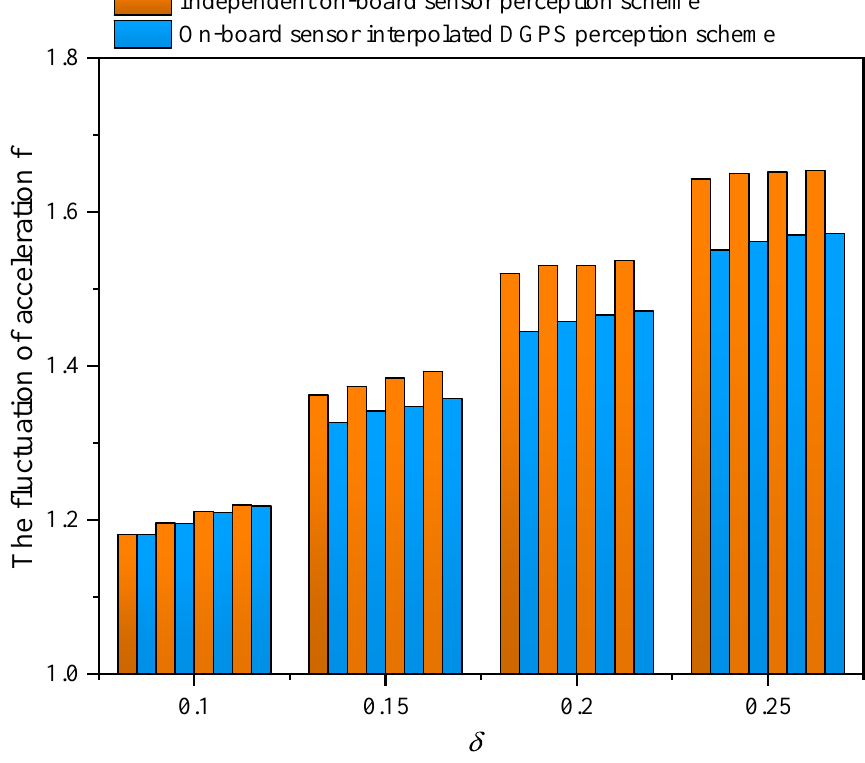
Figure 11. The fluctuation of vehicle acceleration for varying perceptual error size δ with an inde- pendent on-board sensor perception scheme and an on-board sensor interpolated DGPS perception scheme in a partial CAV scenario. The data correspond to 80%, 60%, 40%, and 20% CAV penetration from left to right at each δ